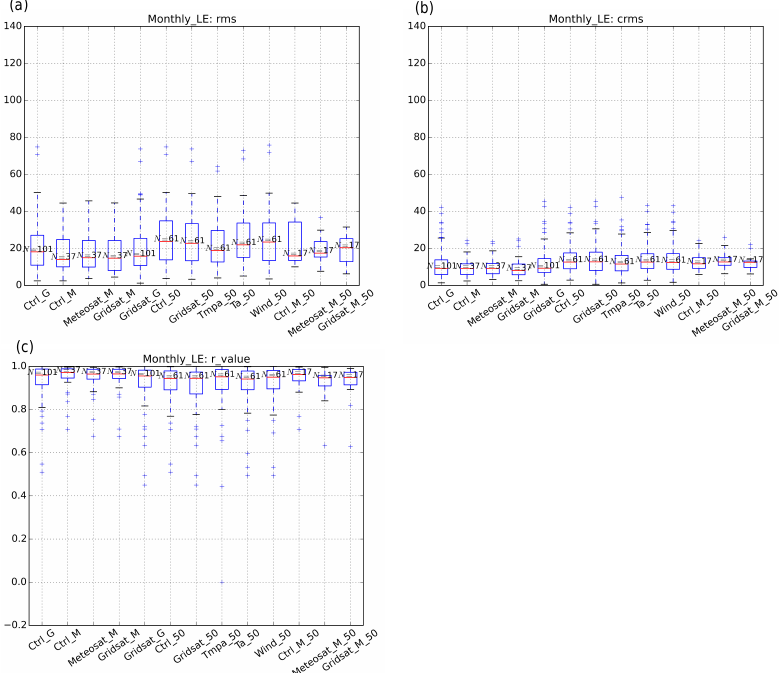
Figure D4. Similar error statistic for LE like in Fig. 8 but for monthly values: (a) RMSD, (b) cRMSD, (c) correlation